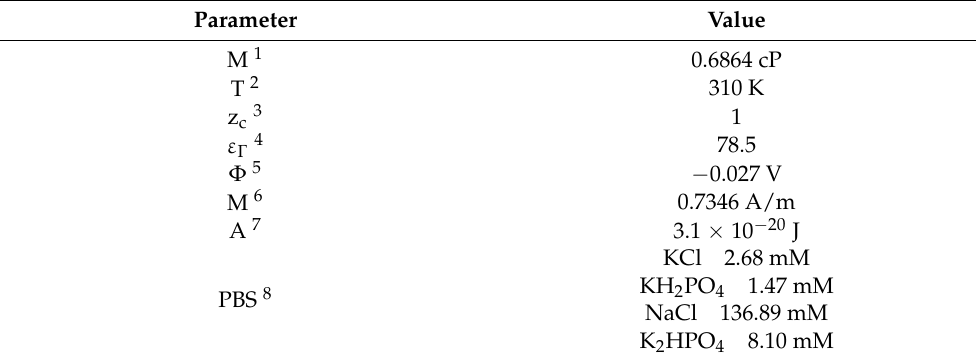
Table 1. Parameters used in the